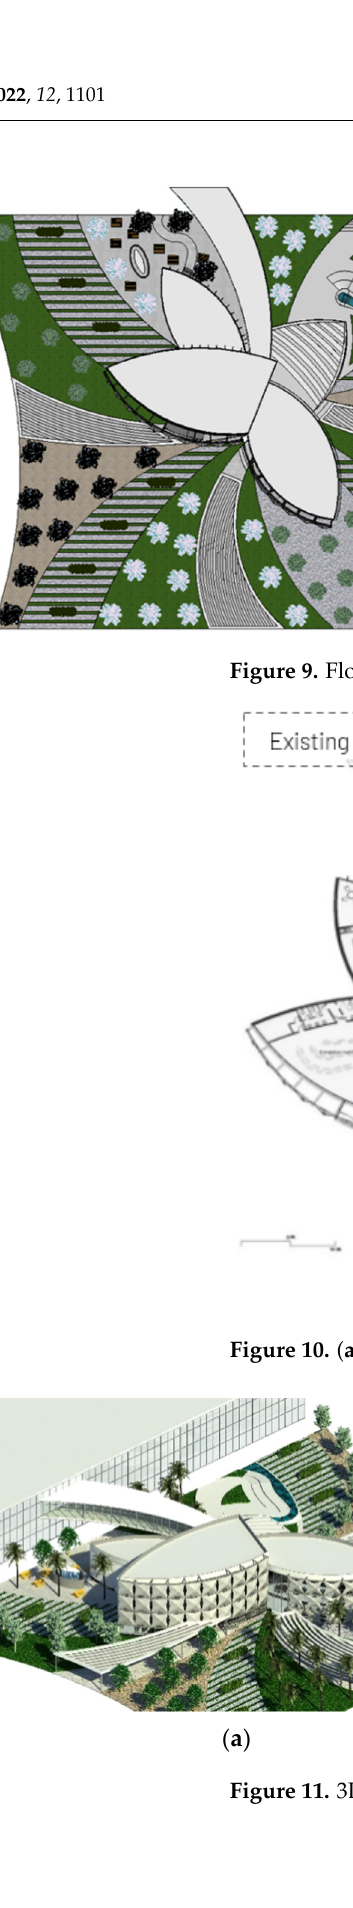
Figure 12. South elevation. Figure 13. East elevation. Figure 14. West elevation.